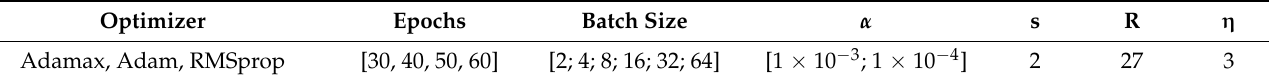
Table 3. Hyperparameter reduced search space.